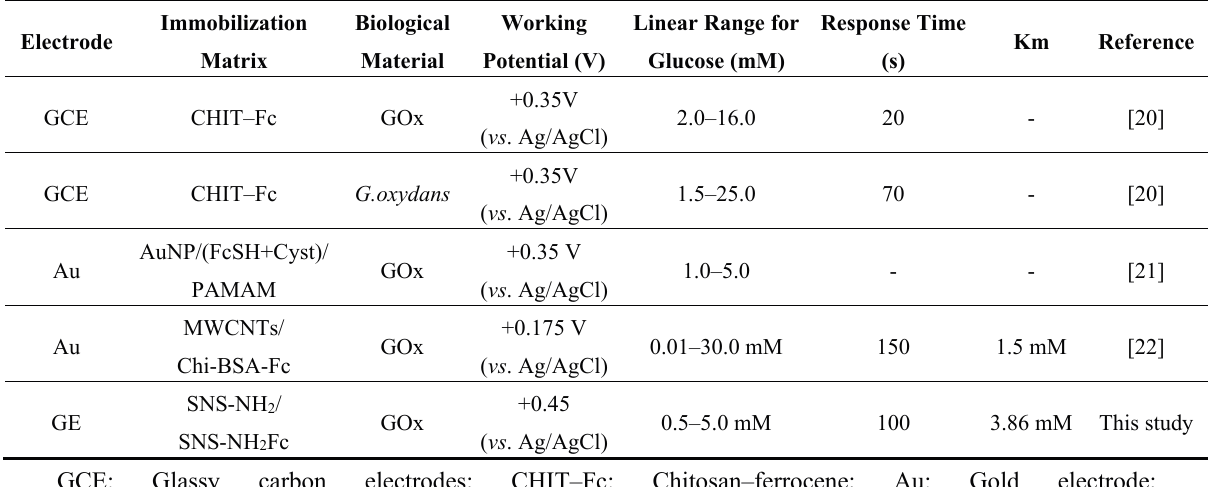
Figure 7. A typical chronoamperometric signal of SNS-NH 2 /SNS-NH 2 -Fc/GOx and SNS-NH 2 -Fc/GOx biosensor after glucose addition (in sodium acetate buffer, 50 mM, pH 4.5, +0.45 V, [Glucose]: 5.0 mM). Table 2. Some features of glucose biosensors which prepared using immobilized Fc in the